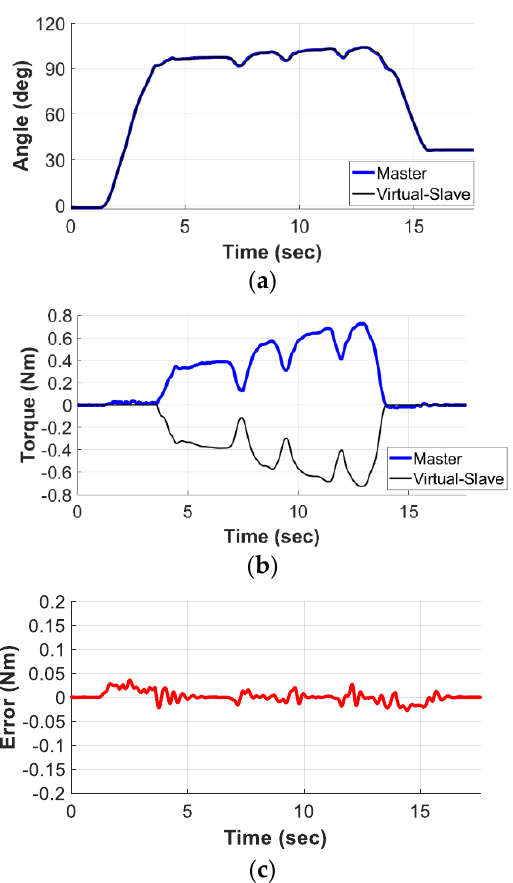
Figure 11. Results of bilateral control using proposed magnetic coupling with the disturbance compensation method: ( a ) position responses; ( b ) torque responses; ( c ) torque error.